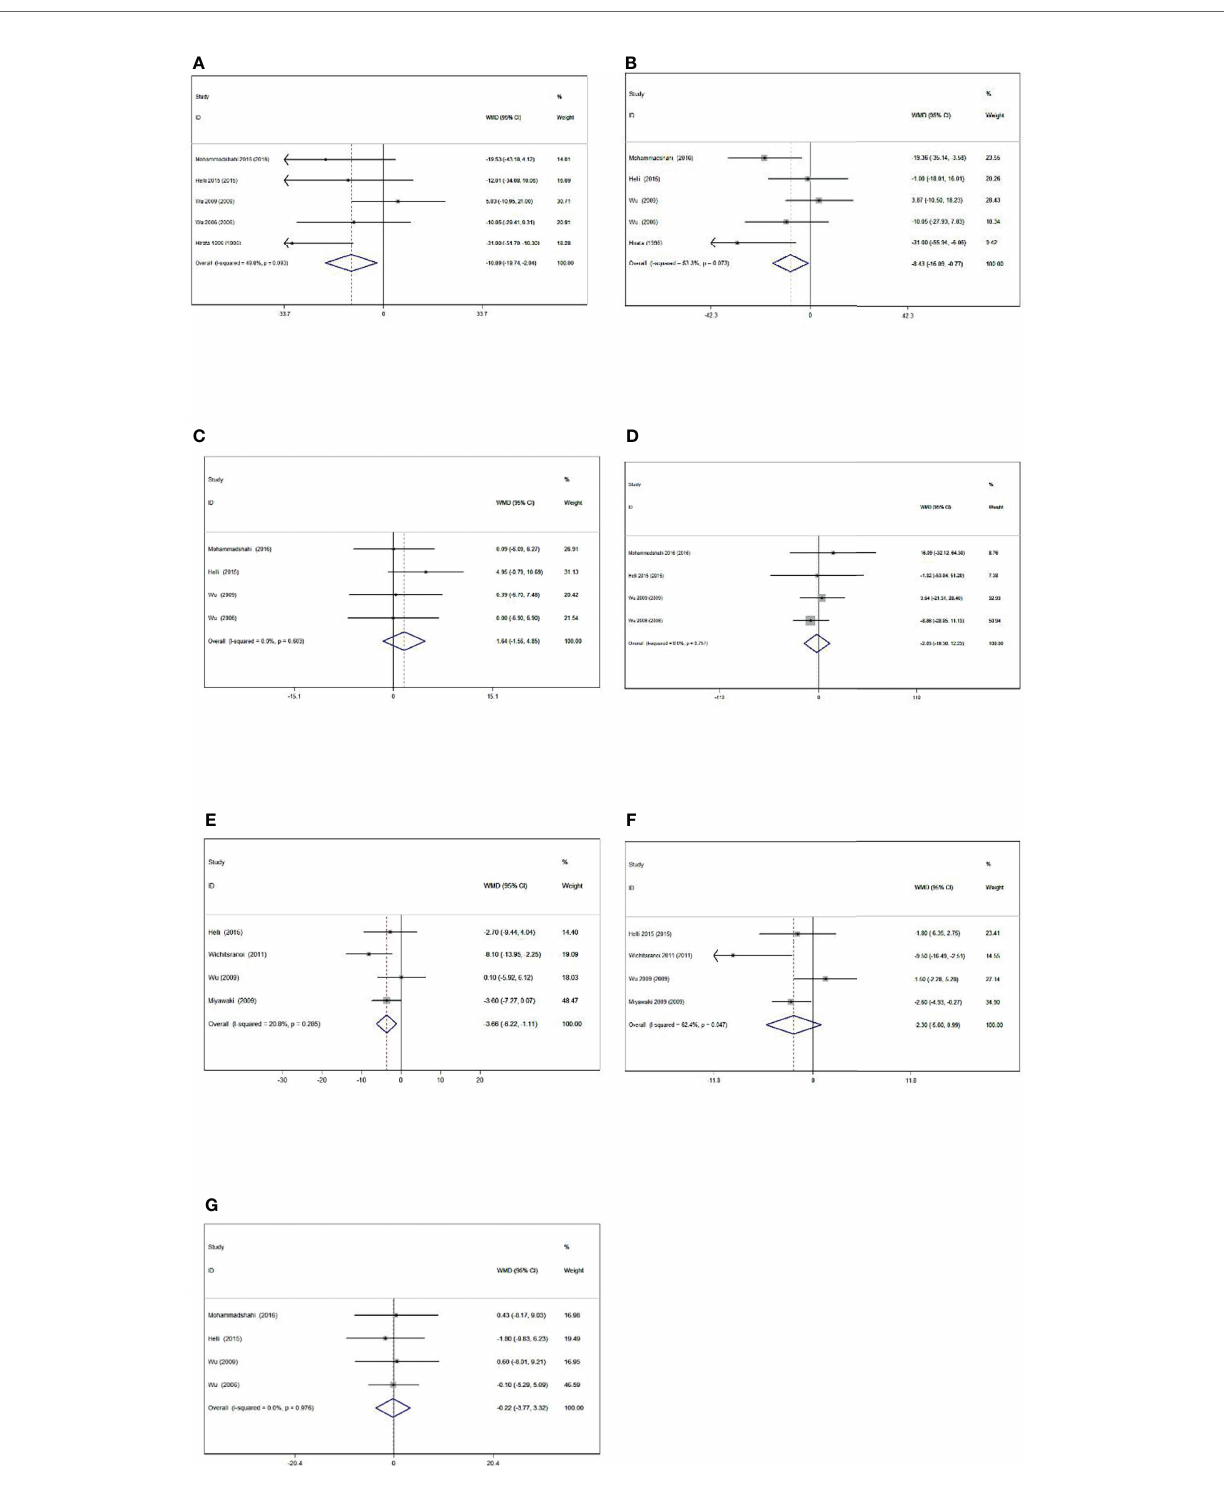
FIGURE 2 | Forest plot of the effect of sesamin supplementation on TC (A) , LDL-c (B) , HDL-c (C) , TG (D) , SBP (E) , DBP (F) , and weight (G)